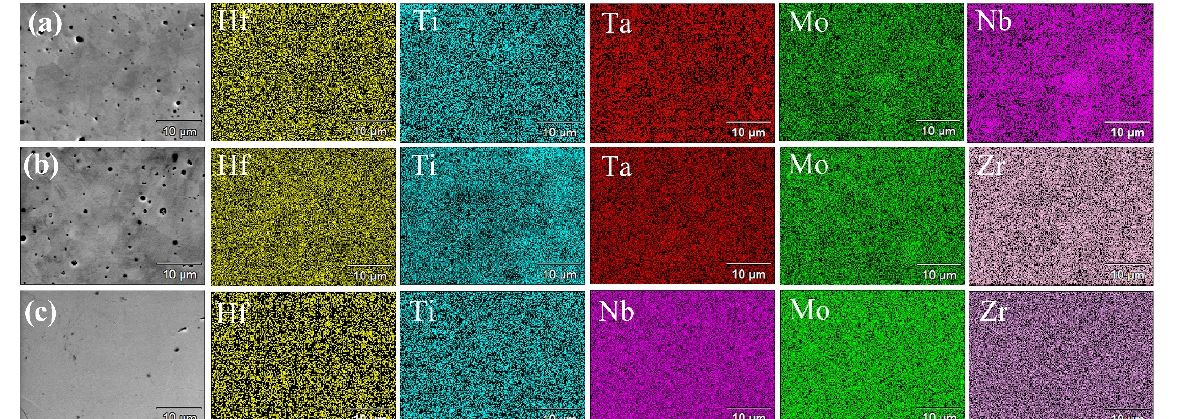
Figure 3. XRD pattern and related Rietveld refinement of dense HE products obtained by SPS.